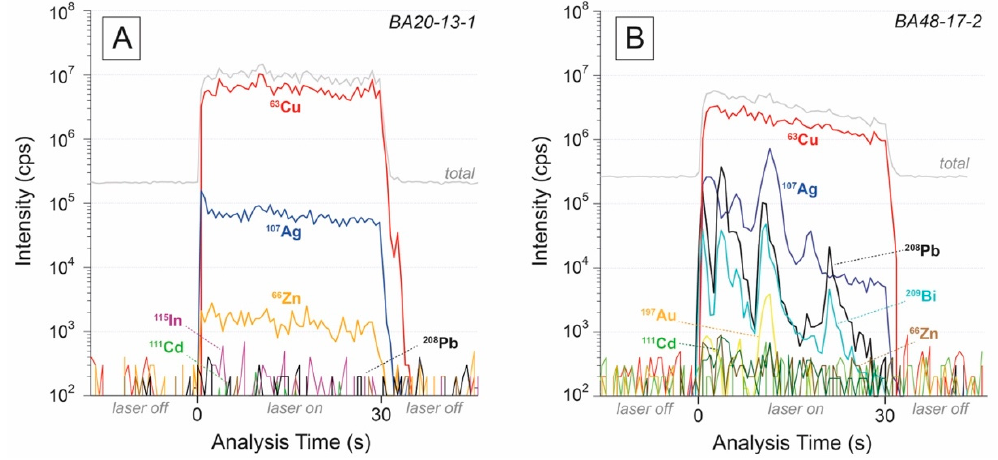
Figure 4. Time (s) vs. intensity (cps) laser ablation inductively coupled plasma mass spectrometry (LA-ICP-MS) depth-concentration profiles of selected isotopes in chalcopyrite from Cerro Pabellón. The 107 Ag spectrum in ( A ) shows a flat profile, suggesting Ag incorporation into solid solution in chalcopyrite (or as nanoparticles not resolved in the LA-ICP-MS profiles). In contrast, the spiky 107 Ag signals in ( B ) are indicative of Ag being present as micro-inclusions in chalcopyrite.